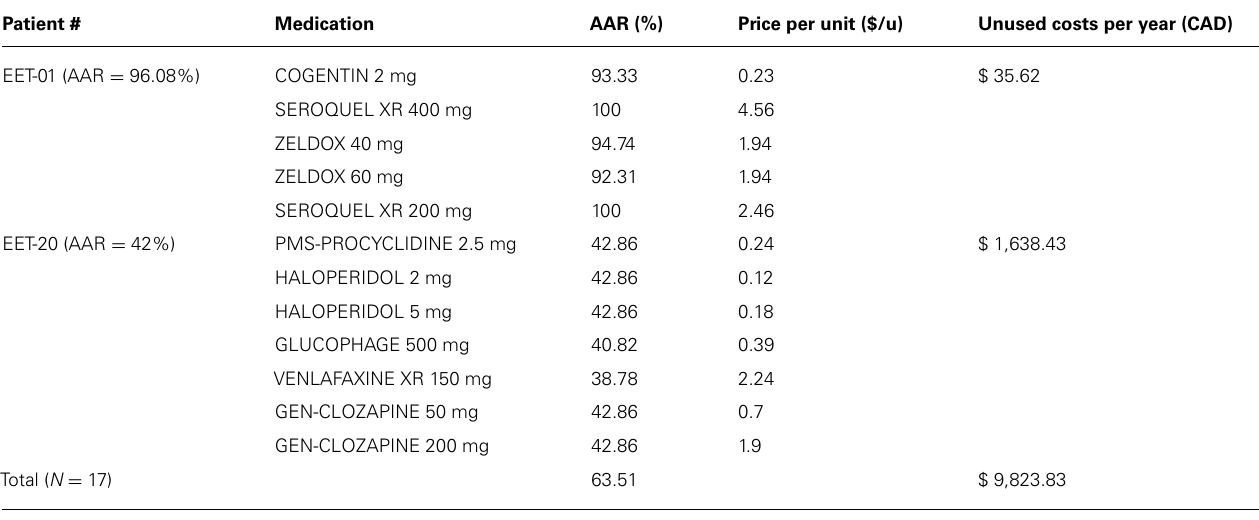
Table 3 | Estimation of non-adherence costs in our sample of schizophrenia patients ( N = 17). Example of two patients from the “Enriched Environment withTechnology” (EET)